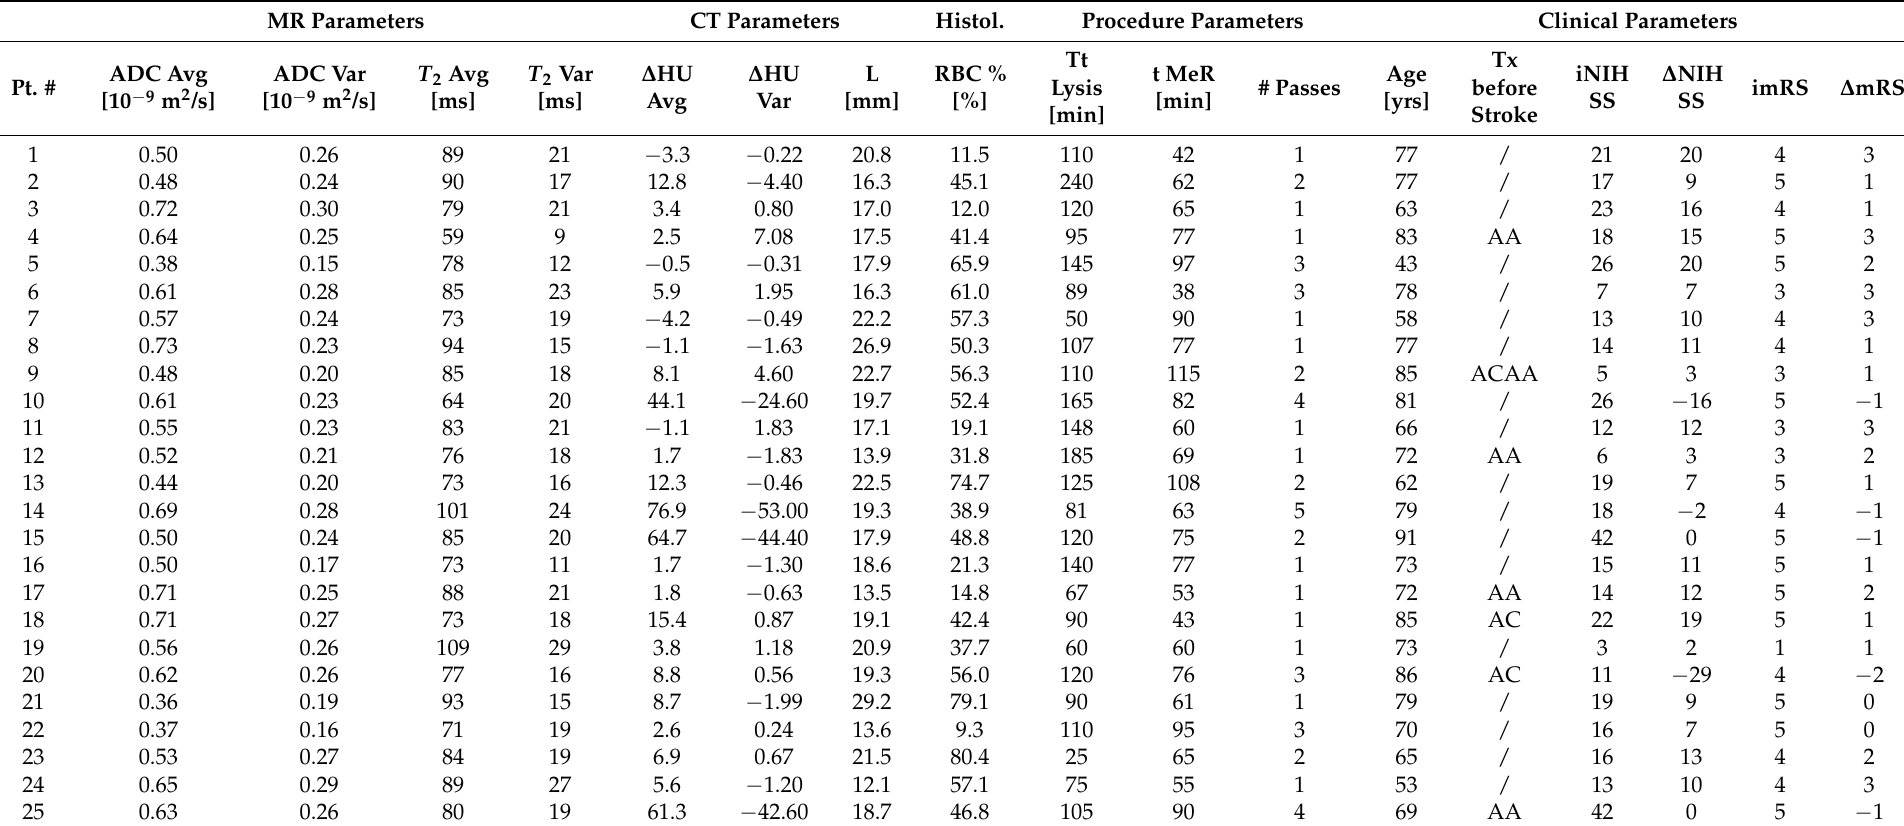
Table 1. MRI, CT, histological, interventional procedure and clinical parameters of patients diagnosed with ischemic stroke due to occlusion in the MCA artery that were qualified for the study. MR Parameters CT Parameters Histol. Procedure Parameters Clinical